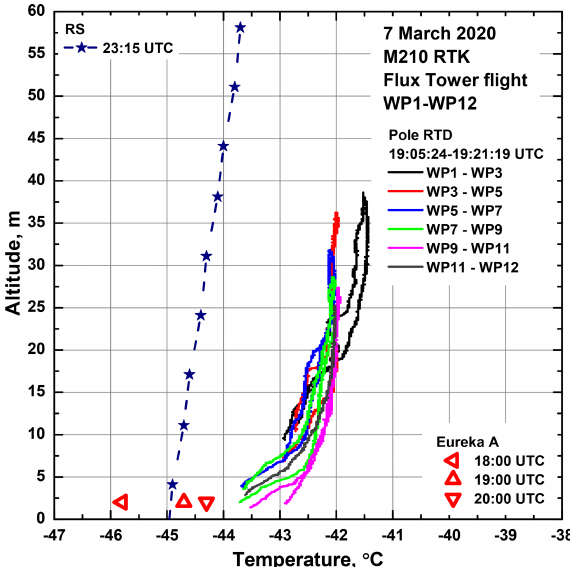
Figure 10. Temperature profiles measured during the M210 RTK flux tower flight along WP1–WP12 waypoints on 7 March 2020. Line colours represent individual profiles in the course of the flight (see Fig. 7 for the locations of the temperature profiles).